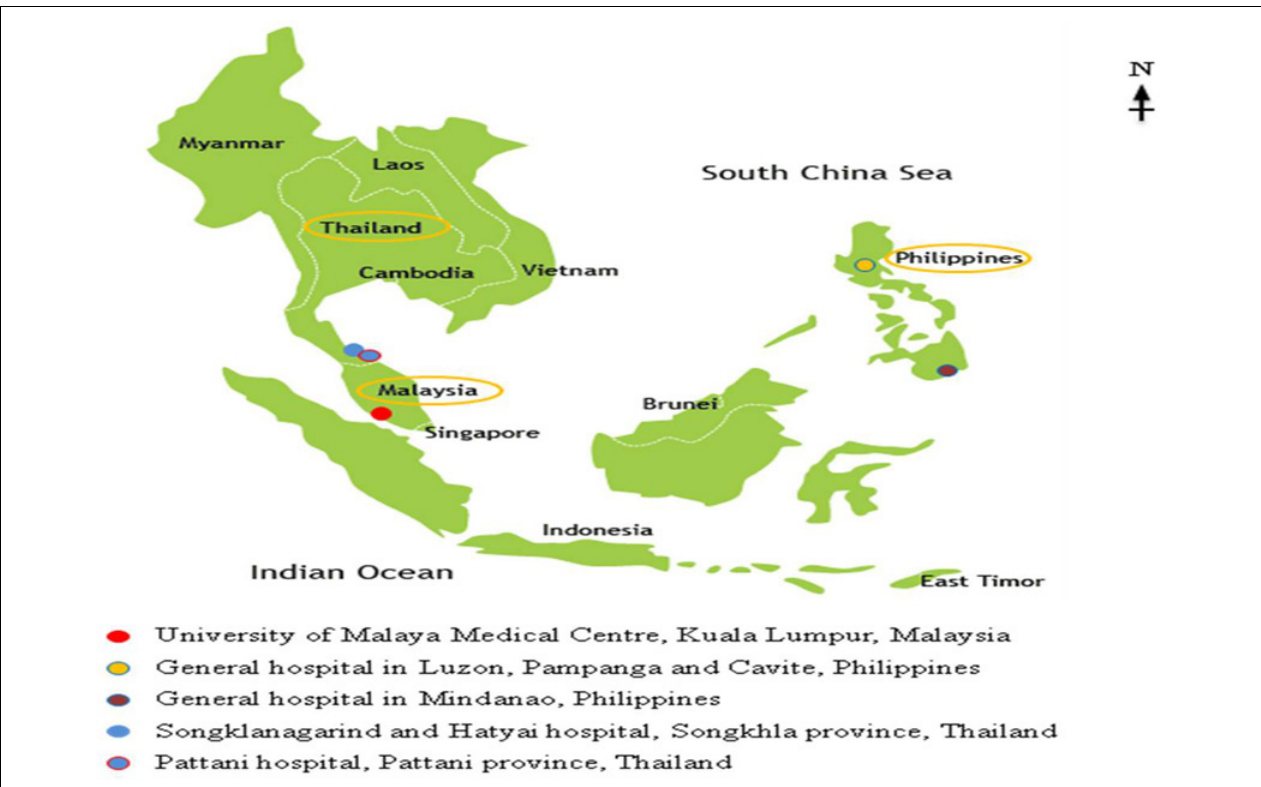
FIGURE 1 | Study sites in Malaysia, Philippines, and